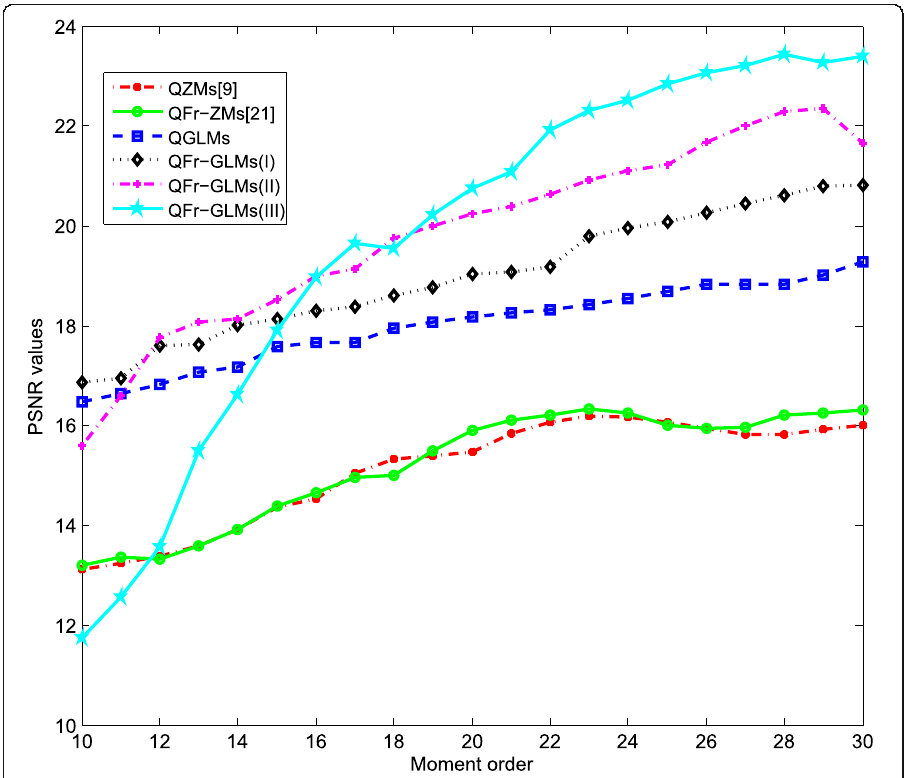
Fig. 4 PSNR versus moment-order curves of different color-image moments